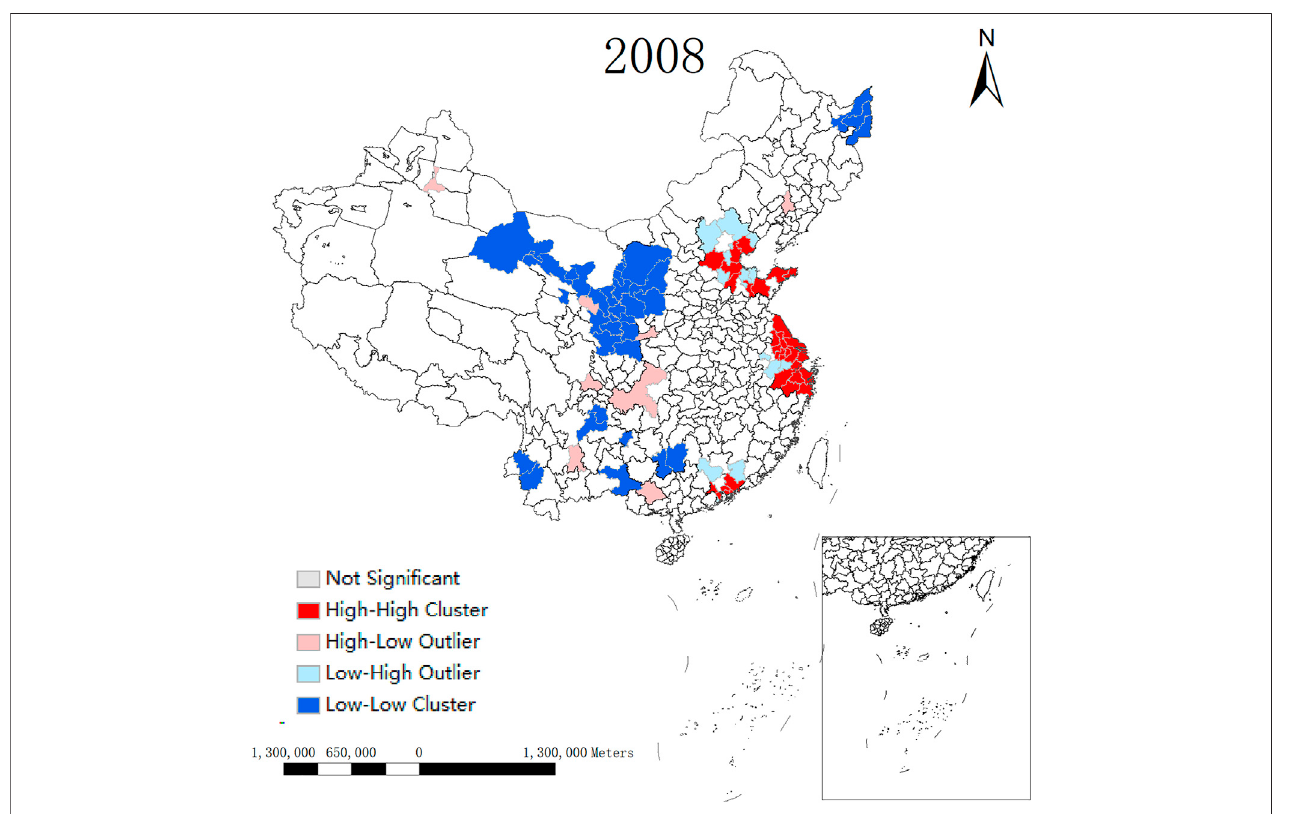
FIGURE 3 | Spatial correlation distribution of urban consumption in